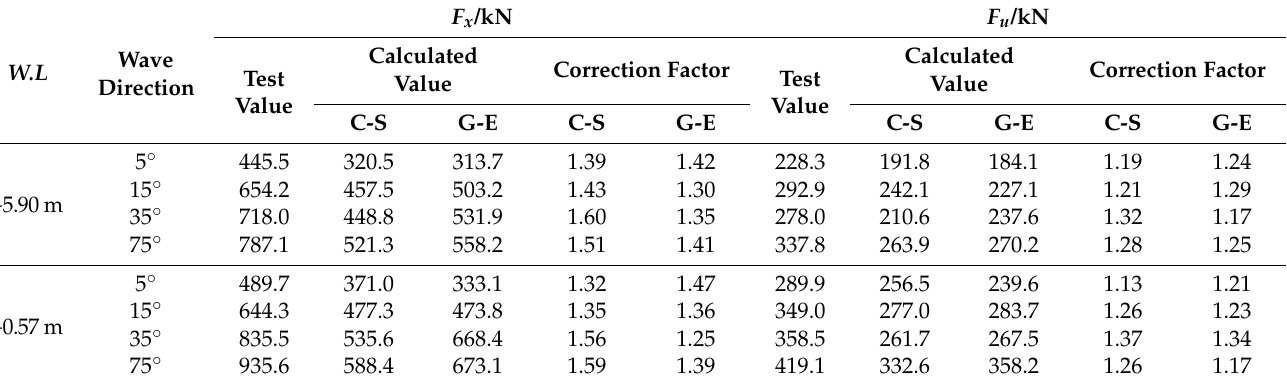
Table 5. Forces on the caissons calculated by tests and specifications under different